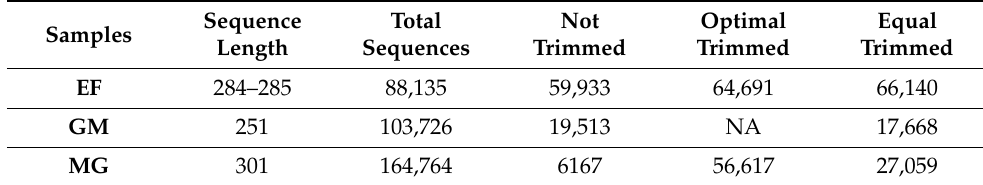
Table 3. Total sequence frequency per sample obtained from three commercial laboratories: EF, GM and MG. Abbreviations: NA—not applicable.